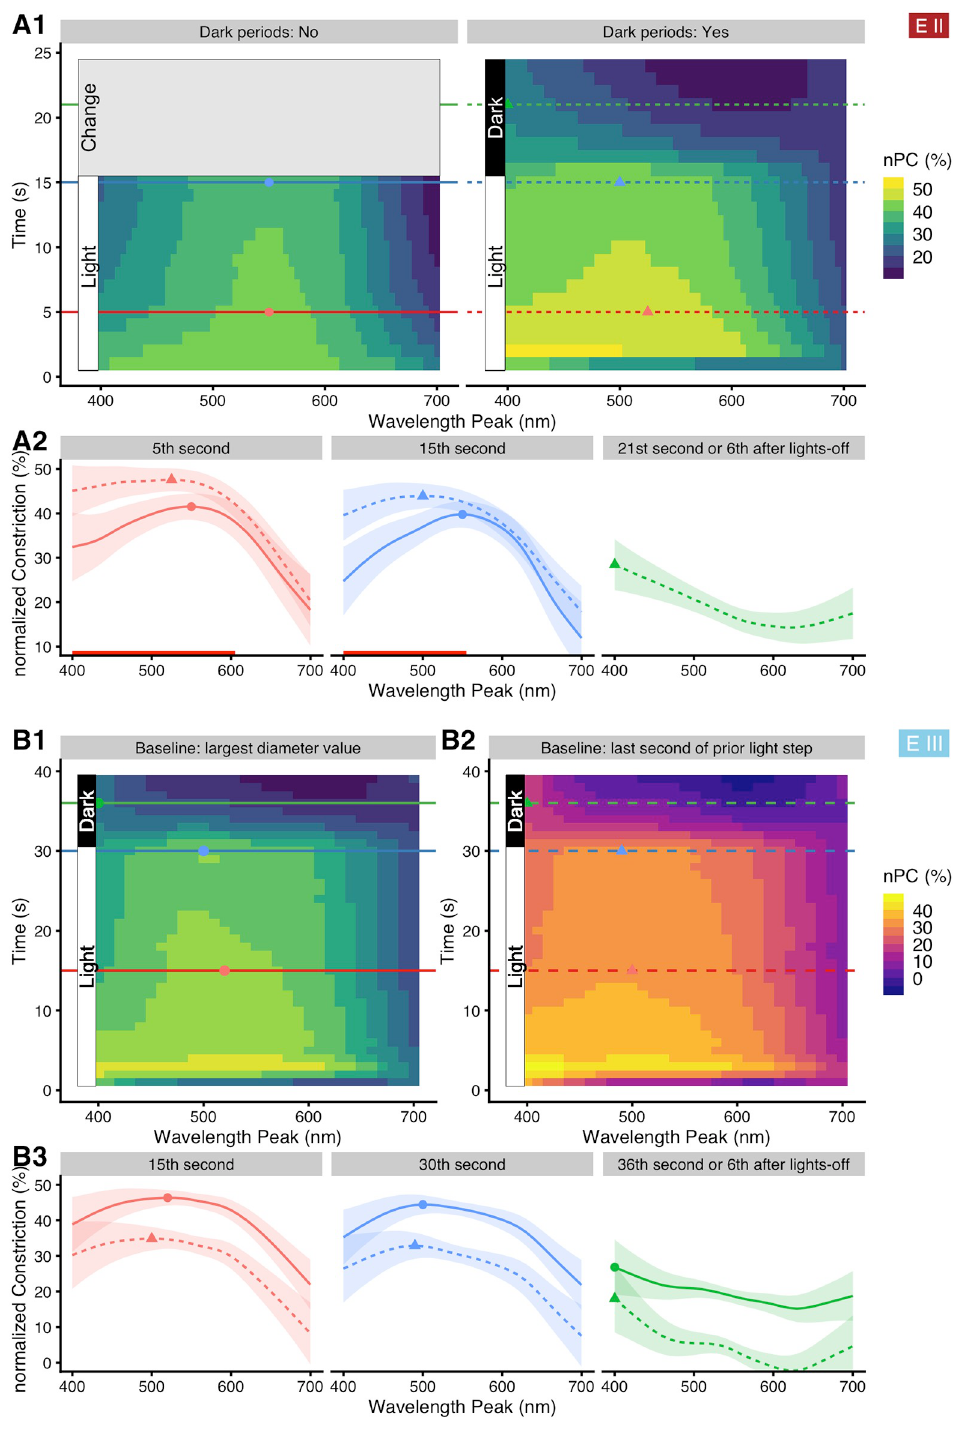
Fig 8. Interaction of wavelength with time in Experiment II and III . Time denotes the time (in seconds) since light onset, or light change to the respective wavelength. (A1) and (A2) show results from Experiment II , (B1), (B2), and (B3) those from Experiment III for the protocols Long 1 and Long 2 . (A1) False-color graph of model predictions for the nPC’s dependence on wavelength (x-axis) and time (y-axis) for settings with (right panel), or without (left panel), periods of darkness between changes of wavelength. All other predictors are held constant at their average value. Horizontal lines indicate where the respective traces shown in figure part (A2) are taken from; continuous curves refer to the absence of dark periods, dashed curves to their presence; filled circles and triangles mark the wavelength of